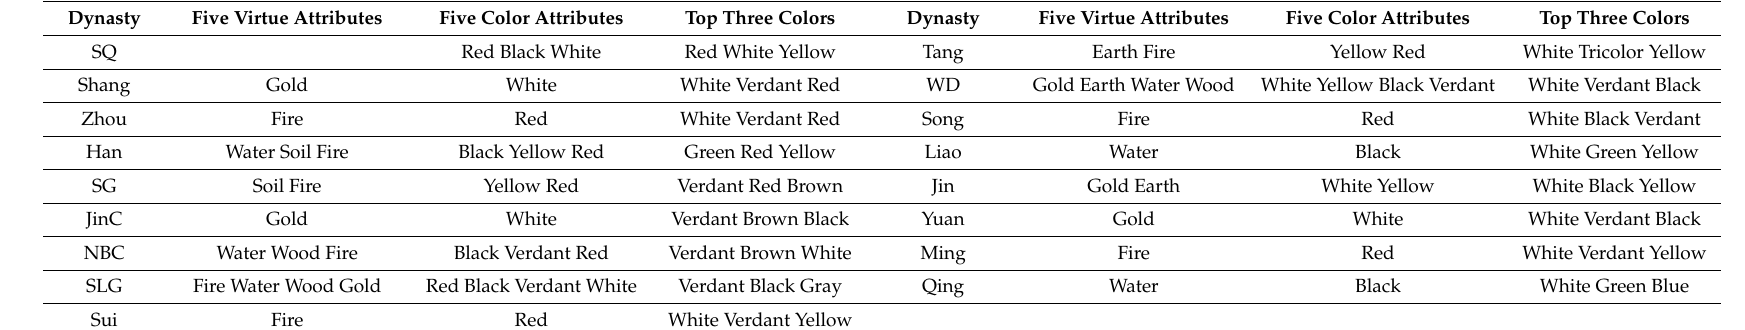
Table 2. Attributes of five virtues and the corresponding five colors in